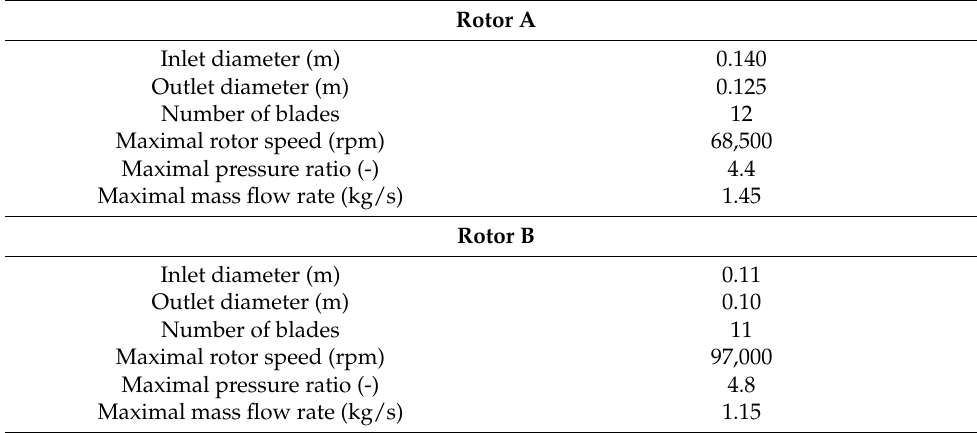
Table 1. The performance data of rotors A and B.